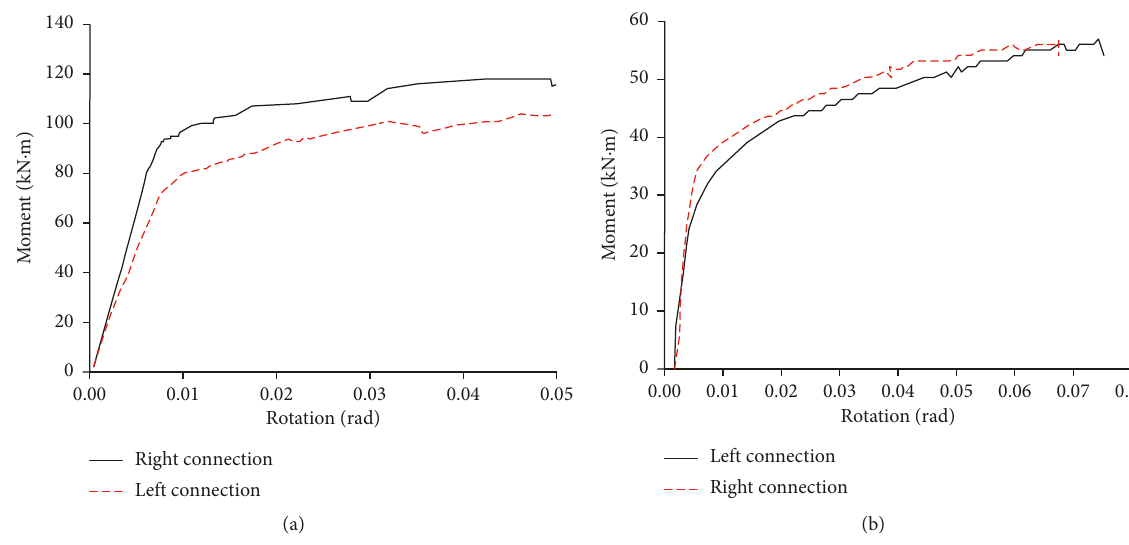
Figure 3: Moment-rotation curves for specimens. (a) Specimen MZ-1. (b) Specimen